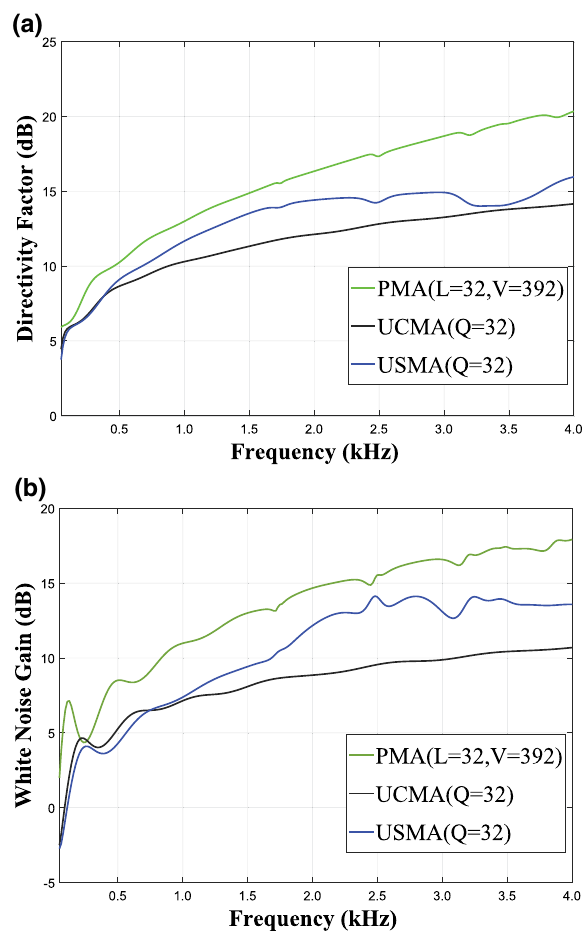
Fig. 5 a The DF and b the WNG of the PMA, the USMA and the UCMA geometries with Q = L =